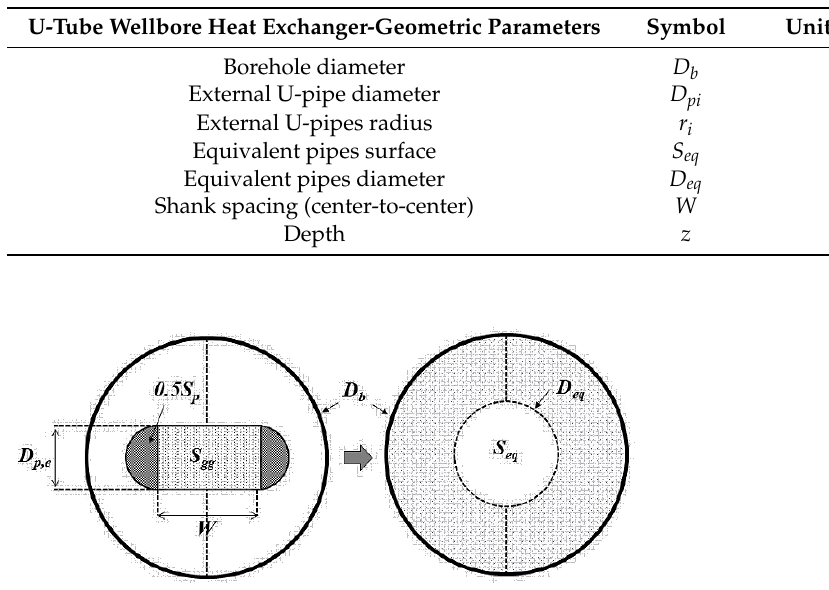
Table 3. U-tube WBHE geometric parameters.